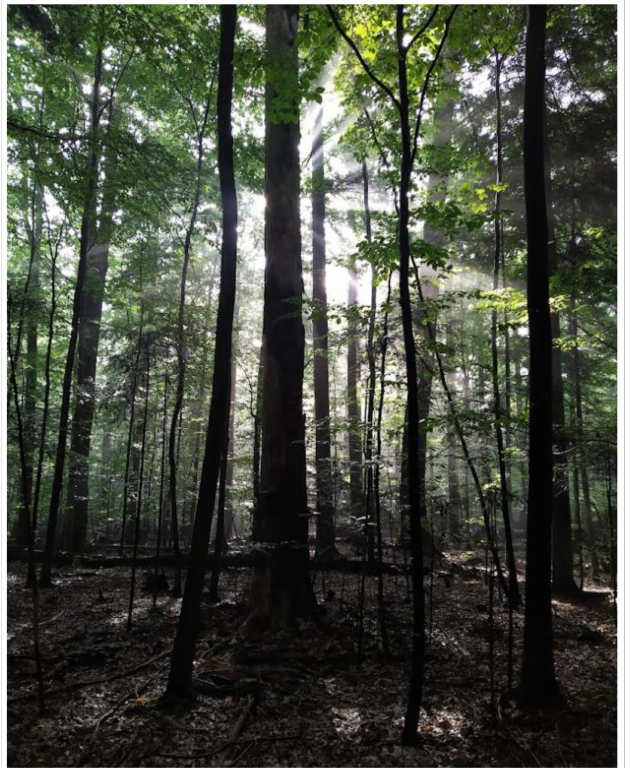
Figure 2. A selection forest in the Holy Cross Mountains in Poland (photo: J.